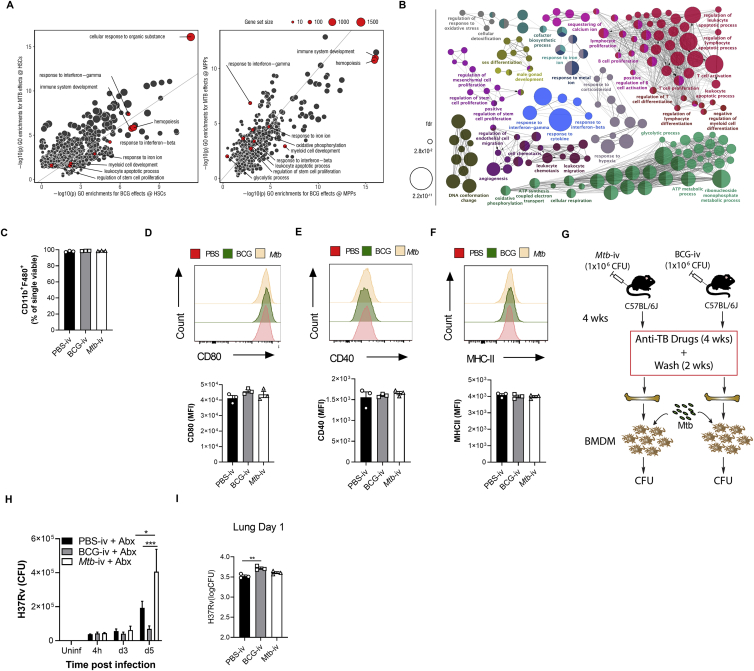
HSC Imprinting by BCG and Mtb-i.v. and Subsequent Anti-mycobacterial Responses by Macrophages to Mtb Infection In Vitro, Related to Figure 2(A) Scatterplot for significance levels (-log10(p value) of gene ontology enrichment analyses conducted among DE genes upon BCG versus Mtb infections in HSC (left) and MPP (right). (B) Gene ontology terms enriched among DEG in response to Mtb in MPP (at FDR < 0.01). (C-F) BMDM from PBS control, BCG-iv and Mtb-iv groups were generated. Purity of BMDM cultures as determined by flow cytometry using expression of BMDM markers CD11b and F4/80 (C). Activation of mature BMDM was assessed by flow cytometry via MFIs of CD80 (D), CD40 (E) and MHC-II (F) with representative histograms in the top panels. Model of in vivo antibiotic treatment (G). BMDM-derived from the BM cells of these mice were infected with Mtb (H37Rv; MOI 1) and the number of CFU was determined at different time points after infection (H). (I) BMDM CFU prior to intratracheal transfer, as detailed in Figures 2H and 2I. Differences determined by One-way ANOVA followed by Tukey’s Multiple Comparisons Test in C-F and I; Two-way ANOVA followed by Tukey’s Multiple Comparisons Test in H.